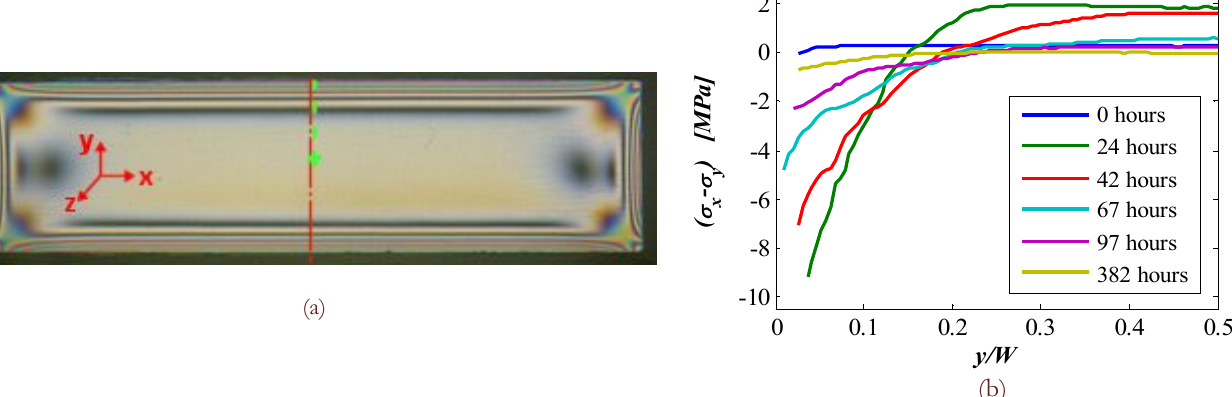
Figure 3: (a) isochromatic map from white light dark field circular polariscope of an un-cracked sample after 48 hours of immersion in the thermal bath; (b) Plot of (  -  ) along the vertical axis of symmetry, going from the sample edge to the sample centre (green x y dashed line), at different aging times.